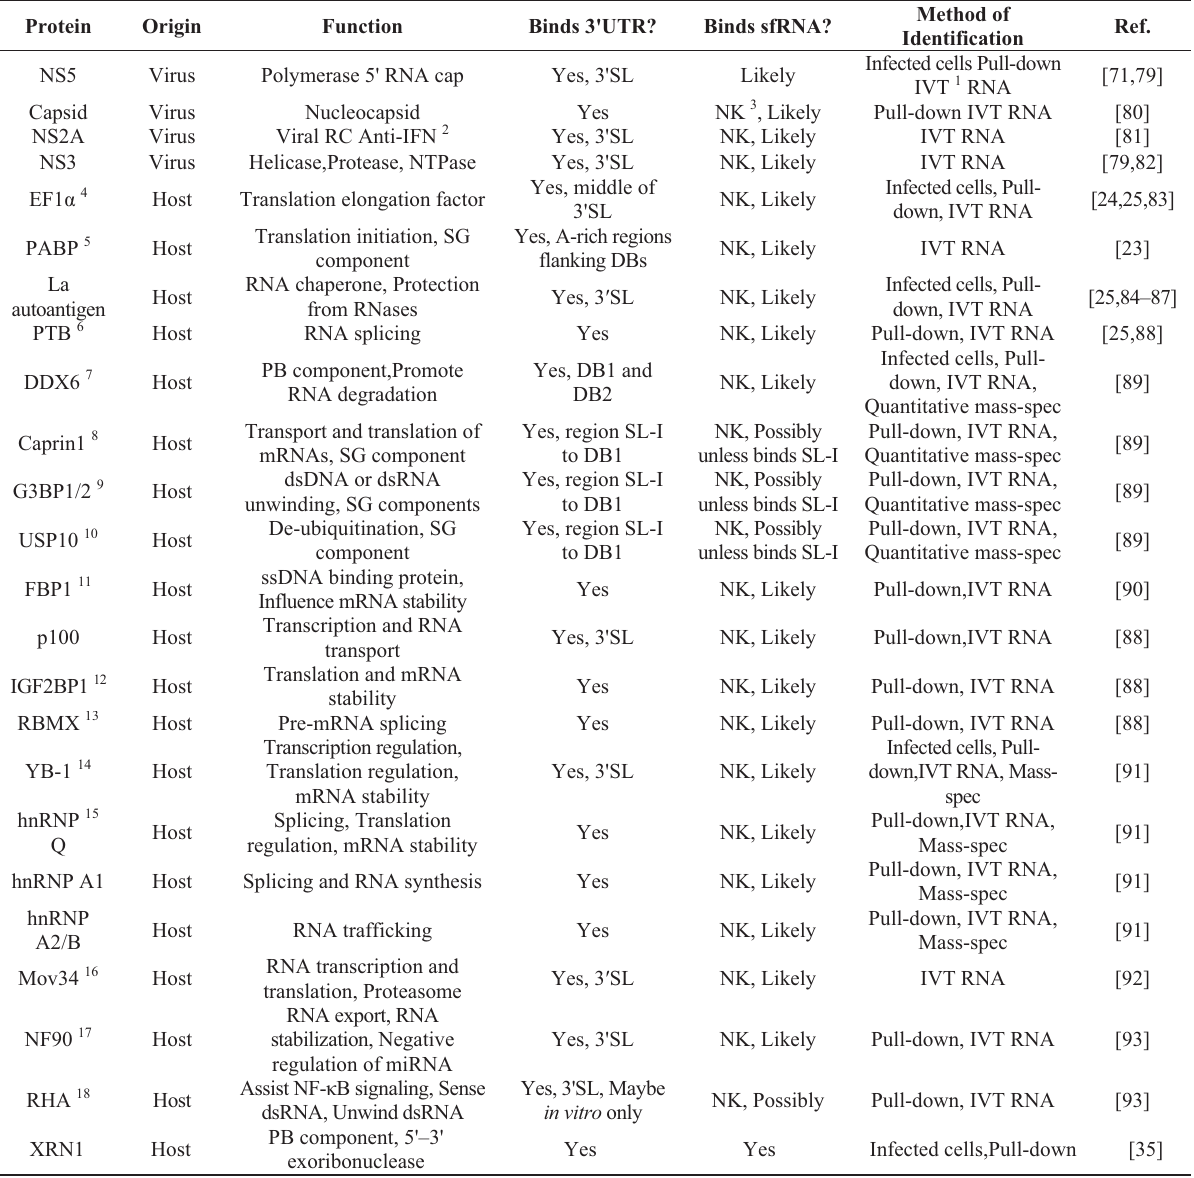
Table 1. Host binding partners of the flavivirus 3'UTR and/or sfRNA. Protein